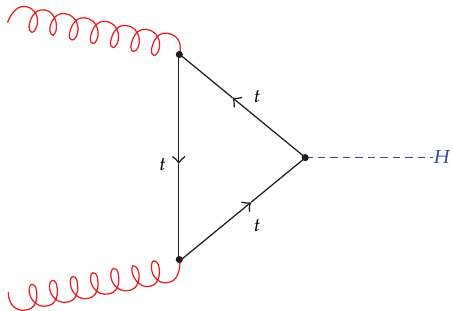
Figure 1: Gluon fusion with an internal top loop turns out to be the dominant Higgs production mechanism at the